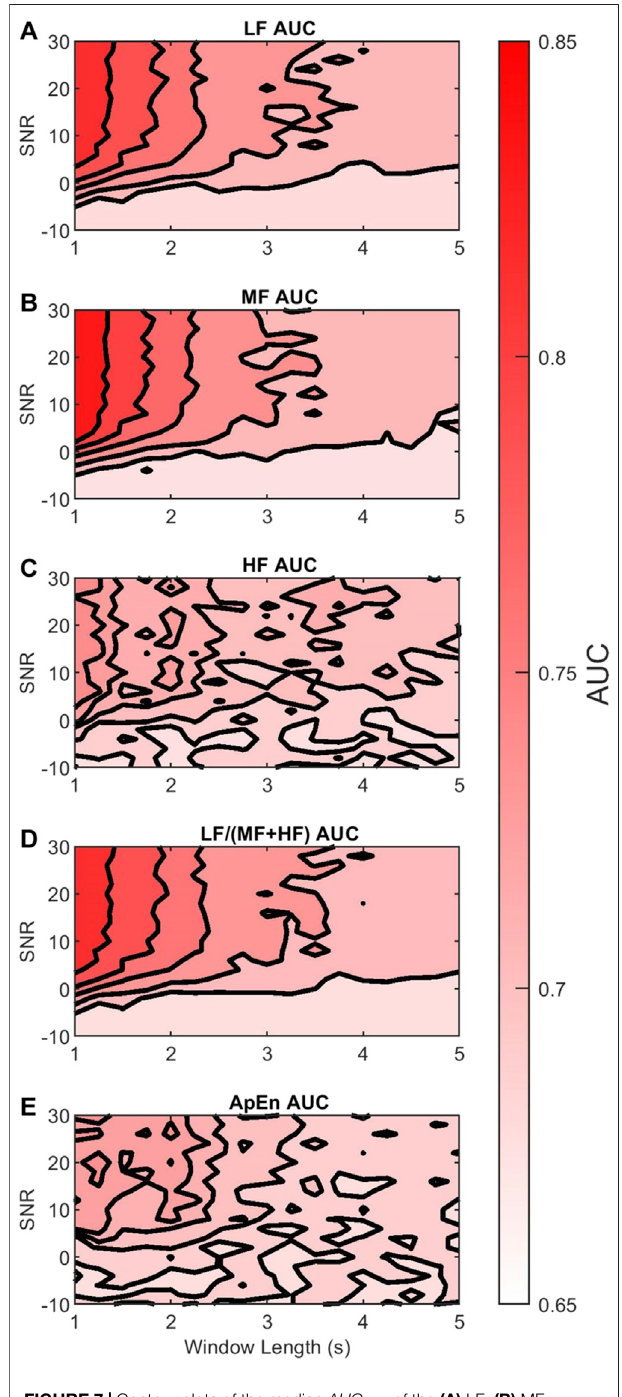
FIGURE 7 | Contour plots of the median AUC DUS of the (A) LF, (B) MF, (C) HF, (D) LF/(MF + HF),and (E) ApEn featuresforvaryingACwindow length (horizontalaxis)andSNR(verticalaxis).The AUC DUS arecodedincolorswhite (0.65), and red (0.85) according to their magnitude. For visualization, 5 isolines are used in each